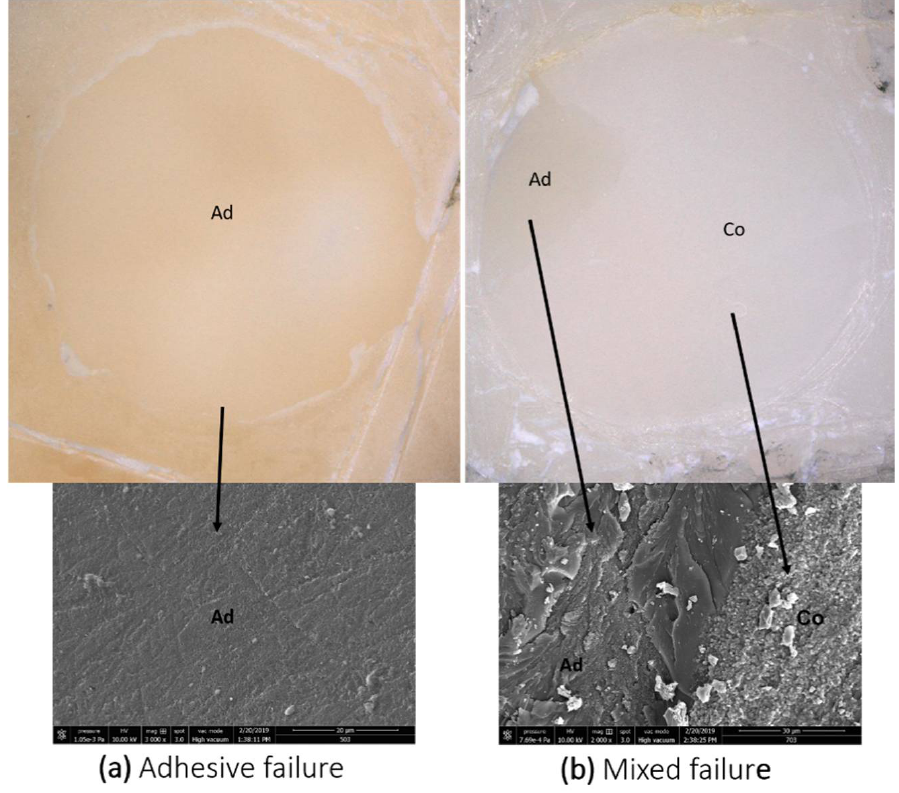
Figure 2. Representative images obtained with optical microscope and scanning electron micros- (SEM). ( a ) Adhesive failure ( × 50 magnification); ( b ) mixed failure ( × 50 magnification). Ad: adhesive; copy (SEM). ( a ) Adhesive failure (×50 magnification); ( b ) mixed failure (×50 magnification). Ad: Co: